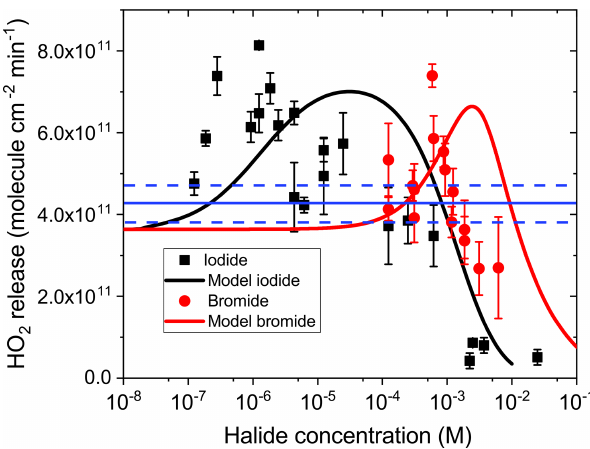
Figure 2. HO 2 release at 34% RH from films with 4mg of IC, 76.8mg of CA, and various concentrations of bromide (red circles) and iodide (black squares). Error bars indicate the standard devia- tion of measurements in the same film. The blue line and the dashed blue lines indicate measured HO 2 production and uncertainty, re- spectively, from films with the same IC and CA concentration but in the absence of halides. Solid black and red lines are fits using the model described in the text below.